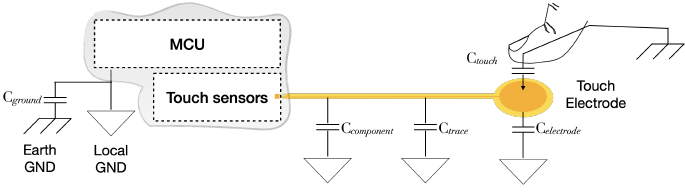
Figure 4. Touch sensor system.